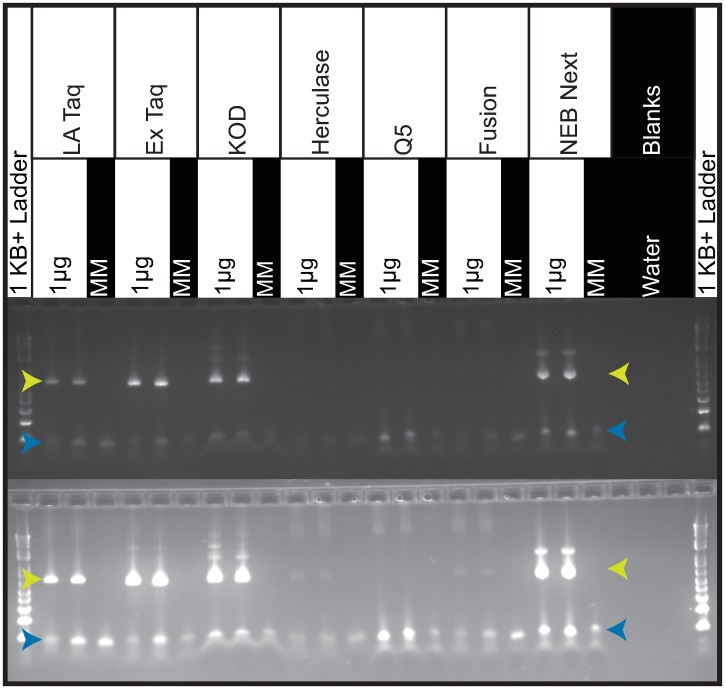
Gel image of PCR products comparing polymerase performance with 1 μg of gDNA input.Product bands are 650nt and indicated with yellow arrows. Blue arrows indicate unused primer bands. Both images are of the same 2% Agarose gel at two different exposures. In both exposures, LA Taq, Ex Taq, KOD and NEB Next produce robust product bands. Herculase and Fusion produce very faint product bands only visible with overexposure. Q5 produced no visible band even with overexposure. The ladder is the 1KB Plus (ThermoFisher, 10787018).